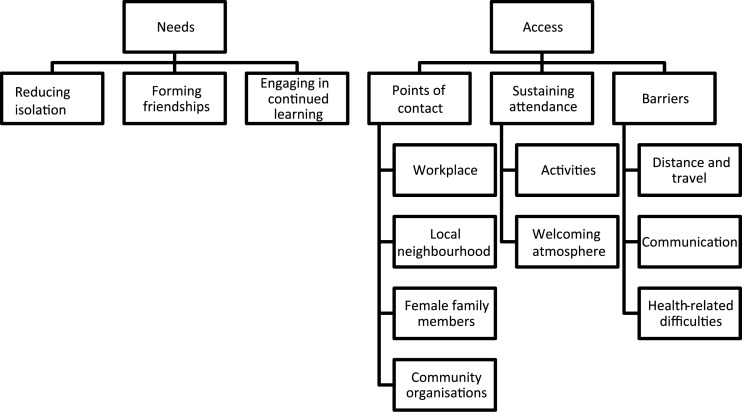
Summary of findings.